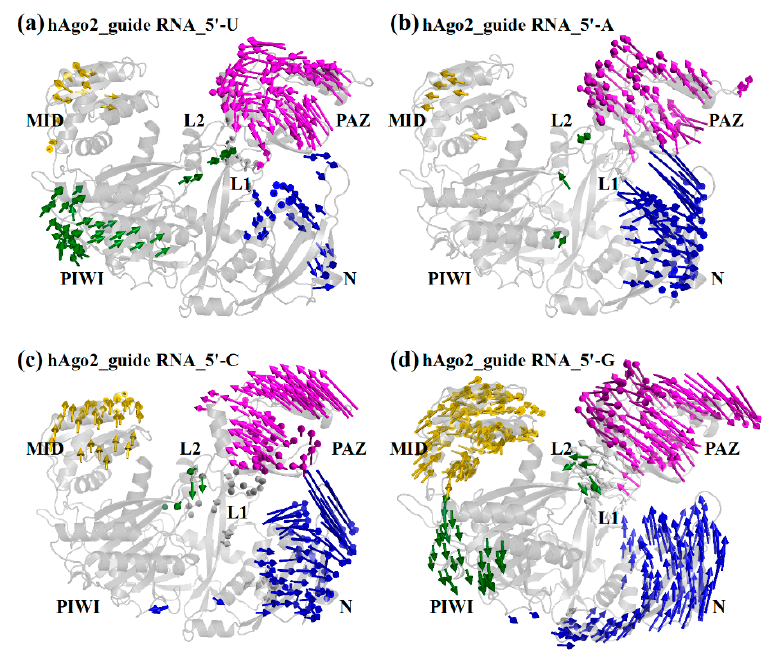
Figure 2. PCA analysis on backbone atoms of hAgo2/guide RNA complexes with different 5 ′ -bases. For clarity, the nucleic acid is not shown. ( a ) U; ( b ) A; ( c ) C; and ( d ) G at the 5 ′ -position of the guide RNA. Color-coding is given in Figure 1.